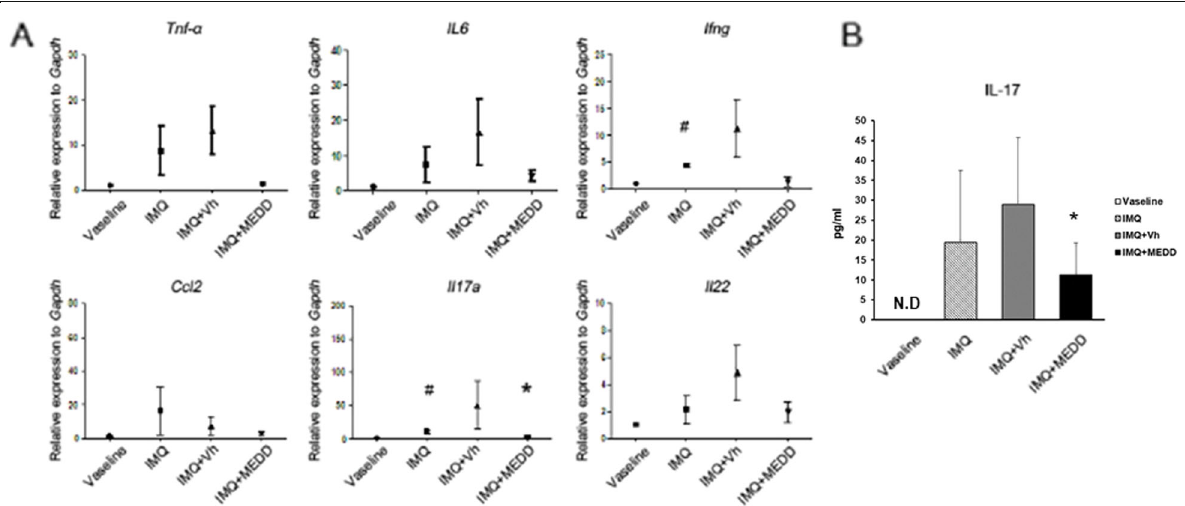
Fig. 2 Effects of MEDD on inflammatory cytokine expression in IMQ-induced psoriasis. The dorsal skin of mice was treated with Vaseline, IMQ, IMQ and Vh or MEDD for 7 days, and cytokine levels were analyzed the next day. a mRNA levels of pro-inflammatory cytokines, Tnf- α , Ifng, Il6, Il17a, Il22, and Ccl2 in dorsal skin. b IL-17A measurement in each group of mouse serum by ELISA. These results represent the mean ± S.D. of four independent experiments. Statistical analysis was performed using Student ’ s t -test. * p < 0.05, compared with mice in the IMQ- and vehicle- treated group; ### p < 0.001, compared with Vaseline control mice; IMQ, imiquimod; Vh, Vehicle; MEDD, methanol extract of Dictamnus dasycarpus root bark; N.D, Not